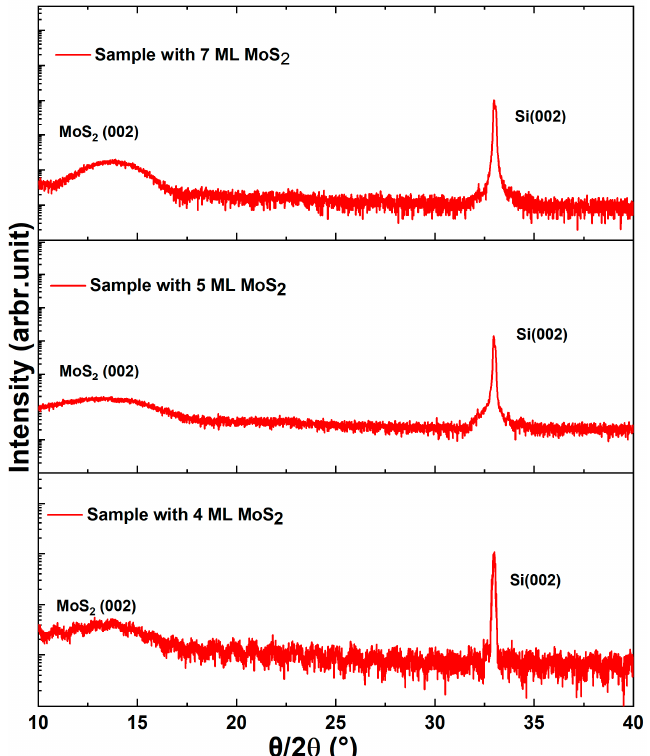
Figure 6. X-ray diffraction on MoS 2 /SiO 2 /Si samples.